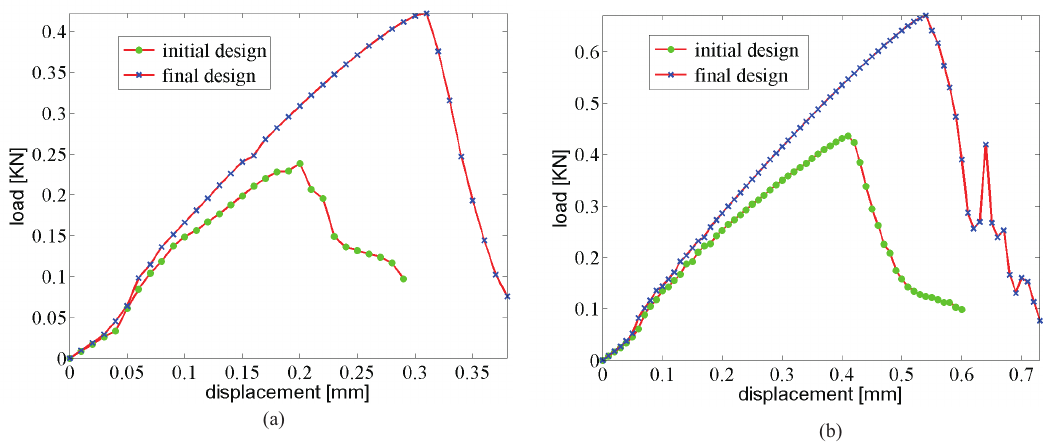
Figure 6. Force–displacement curve for the 3-point bending composite structure: ( a ) 350 × 150 mm 2 , 3 × 7 unit cells; ( b ) 700 × 300 mm 2 , 6 × 14 unit cells.